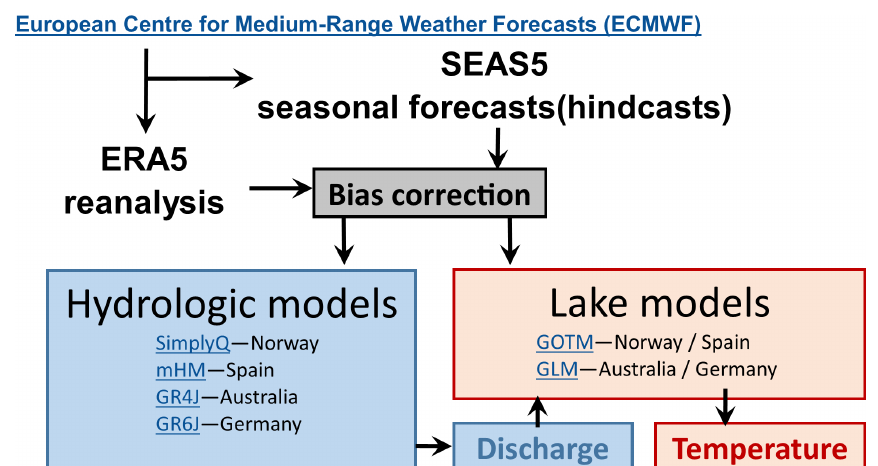
Figure 2. Description of the forecasting workflow. Calibrated hydrologic and lake models are used to produce seasonal lake hindcasts with 25